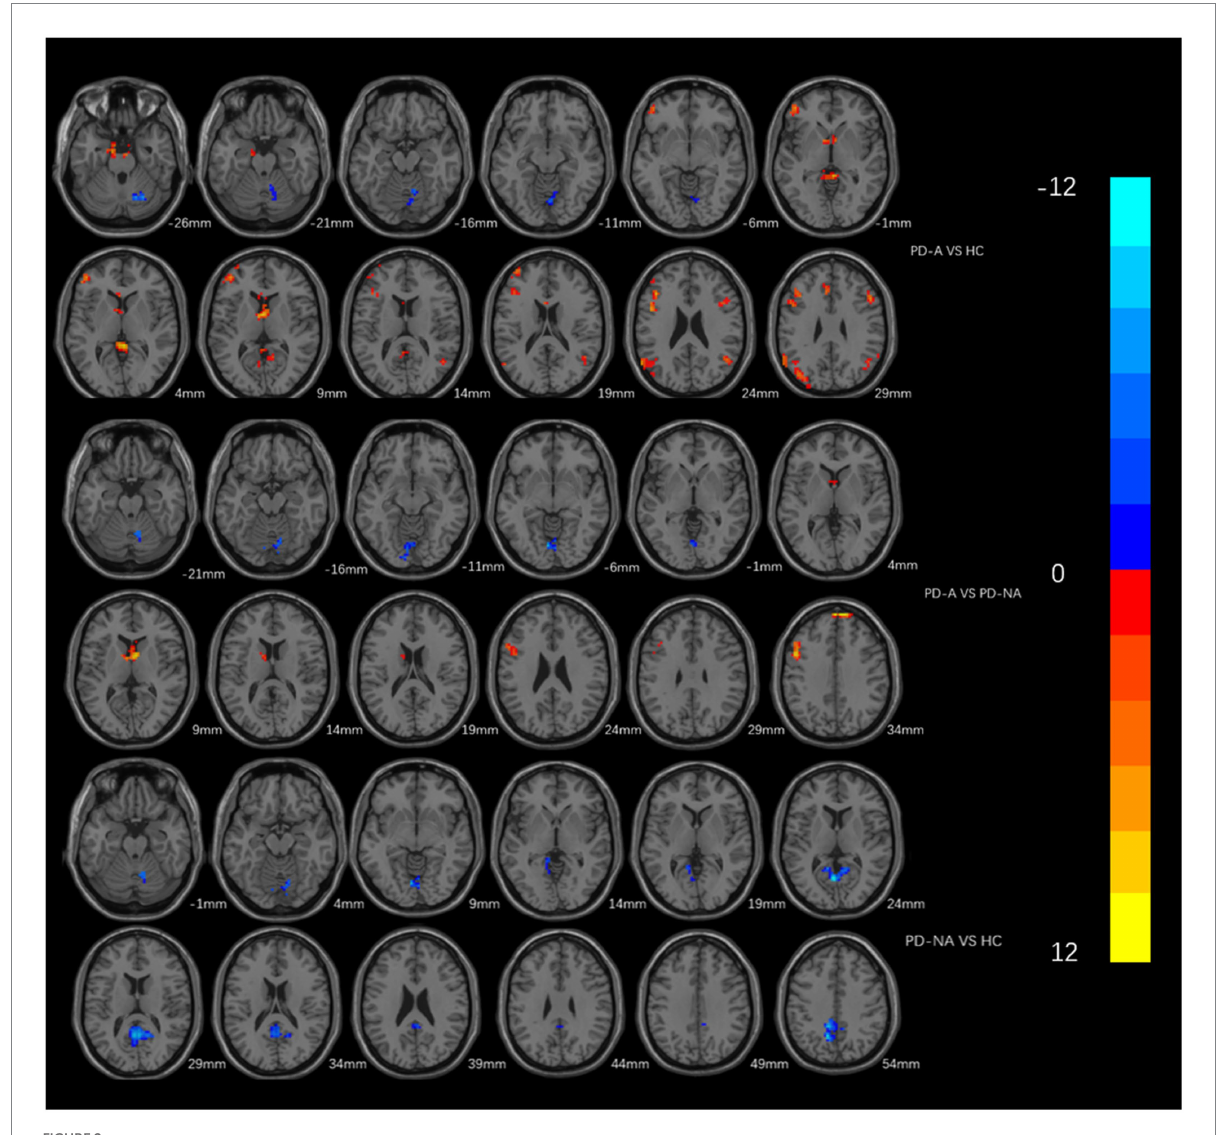
FIGURE 2 Brain areas which showing different Reho between every two groups. The red area represents the brain region with significant increase of ReHo (PD-A>HC, PD-A>PD-NA, PD-NA>HC), and the blue area vice versa (PD-A<HC, PD-A<PD-NA, PD-NA<HC) (GRF multiple comparison correction, P < 0.01 at the voxel level and P < 0.05 at the cluster